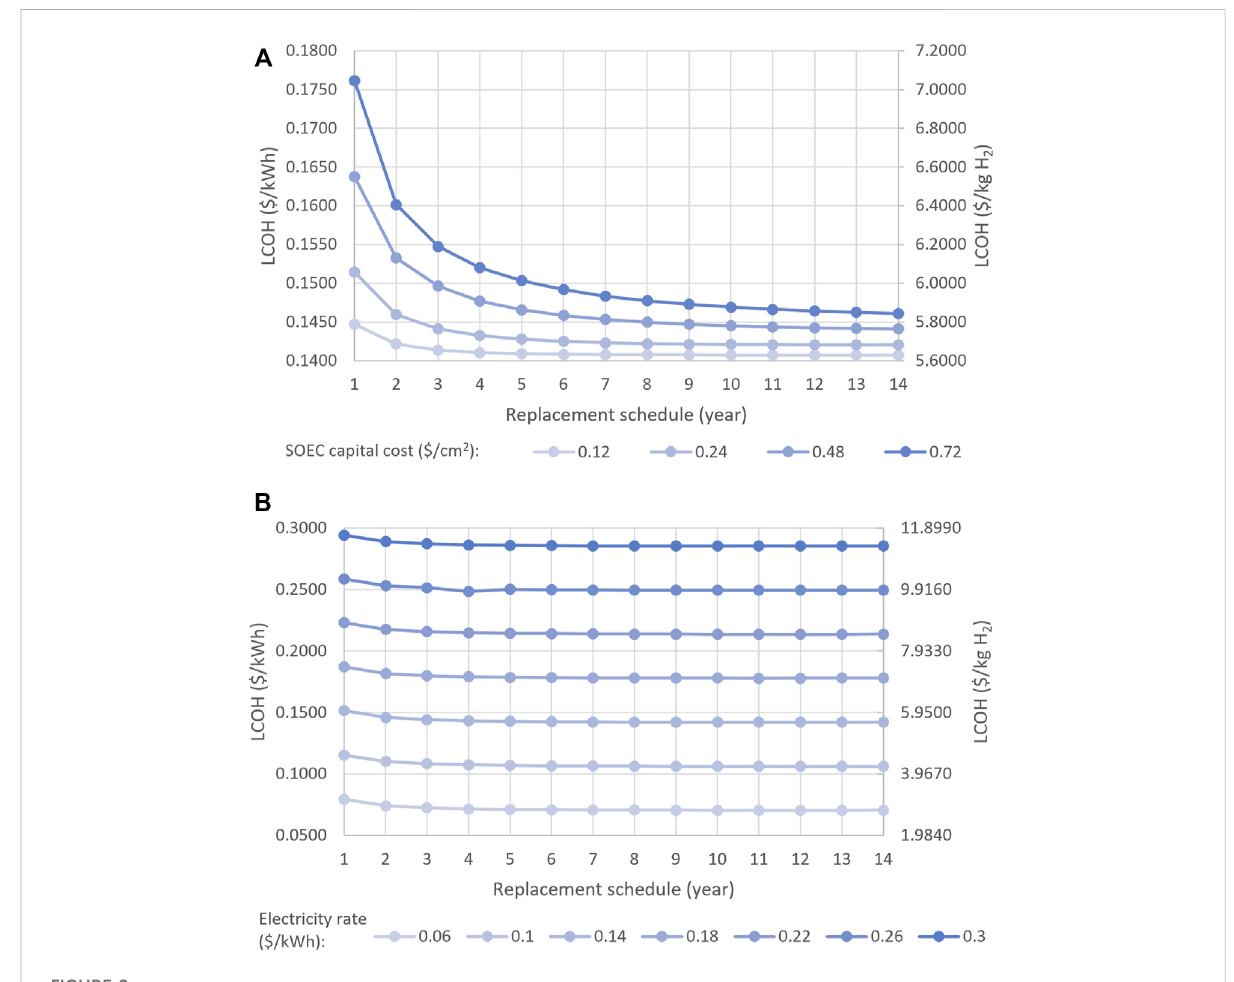
FIGURE 8 Impacts of (A) capital costs (B) electricity price on the LCOH of SOECs with various replacement